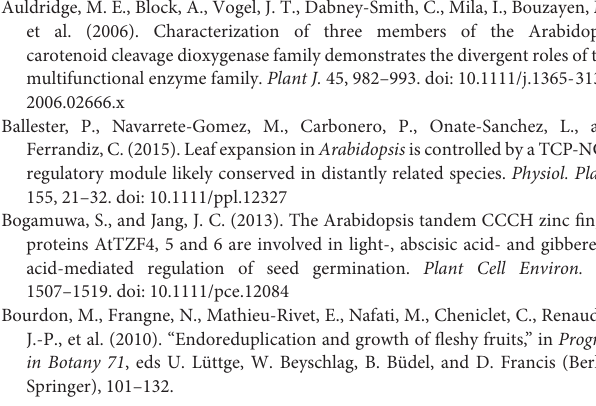
FIGURE S1 | Dry matter content of developing blackcurrant fruit. Dry matter content was estimated following lyophilisation of a single sample comprising 100 fresh fruit as dry weight × 100/fresh weight. FIGURE S2 | Relative proportion of differentially abundant transcripts associated with specific GO terms at different stages of fruit development. White bars indicate the proportion of significantly differentially abundant transcripts within each GO term identifier amongst all of the transcripts differentially abundant at different stages of fruit development: small green (A) , large green (B) , green–red (C) , red–green (D) , red (E) , and ripe (F) . Black bars represent the proportion of genes within each GO-term identifier in the Arabidopsis genome relative to all identified genes in the Arabidopsis genome. GO term descriptions are provided in Supplementary Table S4 . FIGURE S3 | Comparison of relative abundance of transcripts as estimated by microarray analysis and qRT-PCR. Transcripts were chosen as representative of each of the K -means patterns of expression as indicated in Figure 5 . Relative abundance was estimated from the average normalized fluorescence of the appropriate microarray or by the 2 − (cid:49)(cid:49) C t method (Livak and Schmittgen, 2001) following qRT-PCR as described. Panels indicate the relative abundance of transcripts encoding lactate/malate dehydrogenase (comp13106, A ), glycosyl